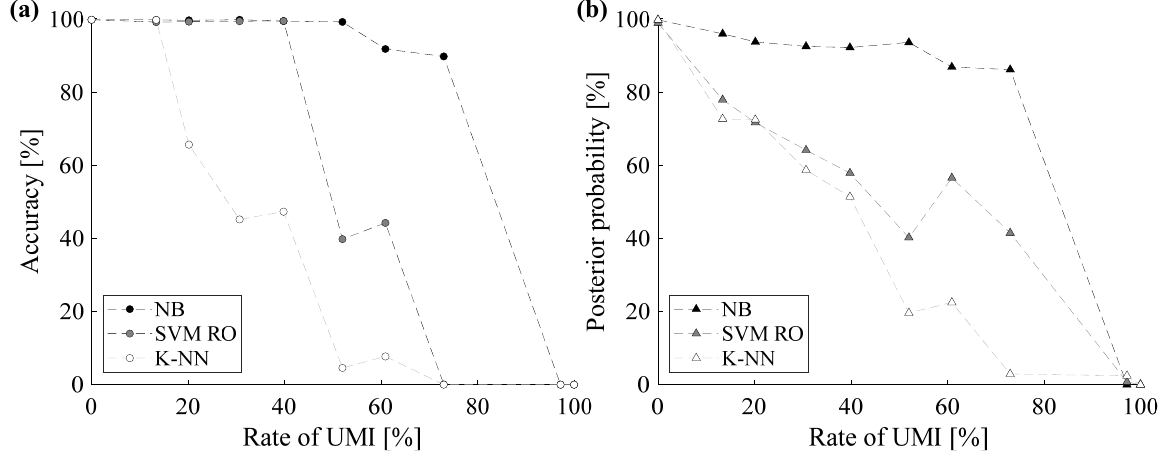
Figure 9. Sensitivity analysis on the rate of UMI (accuracy ( a ); posterior probability ( b )).